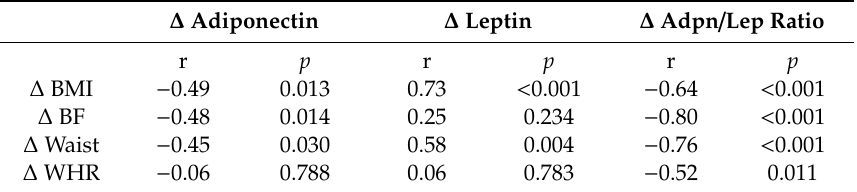
Table 3. Univariate analysis of the correlations between the di ff erences in adiponectin and leptin Table 3 . Univariate analysis of the correlations between the differences in adiponectin and leptin concentrations as well as in the adiponectin / leptin ratio with changes in anthropometric characteristics concentrations as well as in the adiponectin/leptin ratio with changes in anthropometric after Roux-en-Y gastric bypass (RYGB). characteristics after Roux-en-Y gastric bypass (RYGB). ∆ Adiponectin ∆ Leptin ∆ Adpn / Lep Ratio r